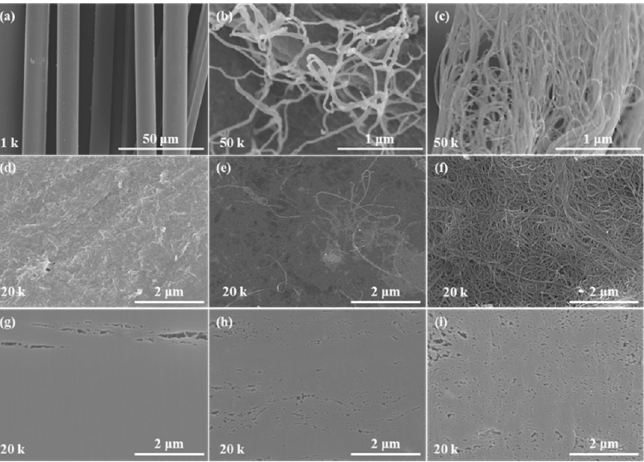
Figure 2. FE-SEM image of ( a ) as-received aramid fiber, ( b ) decomposed ANFs from aramid fiber, and ( c ) as-received SWCNT powder. Surfaces of ( d ) 0_SWCNTs/ANF, ( e ) 50_SWCNTs/ANF, and ( f ) 100_SWCNTs/ANF. Cross-sections of ( g ) 0_SWCNTs/ANF, ( h ) 50_SWCNTs/ANF, and ( i ) 100_SWCNTs/ANF.